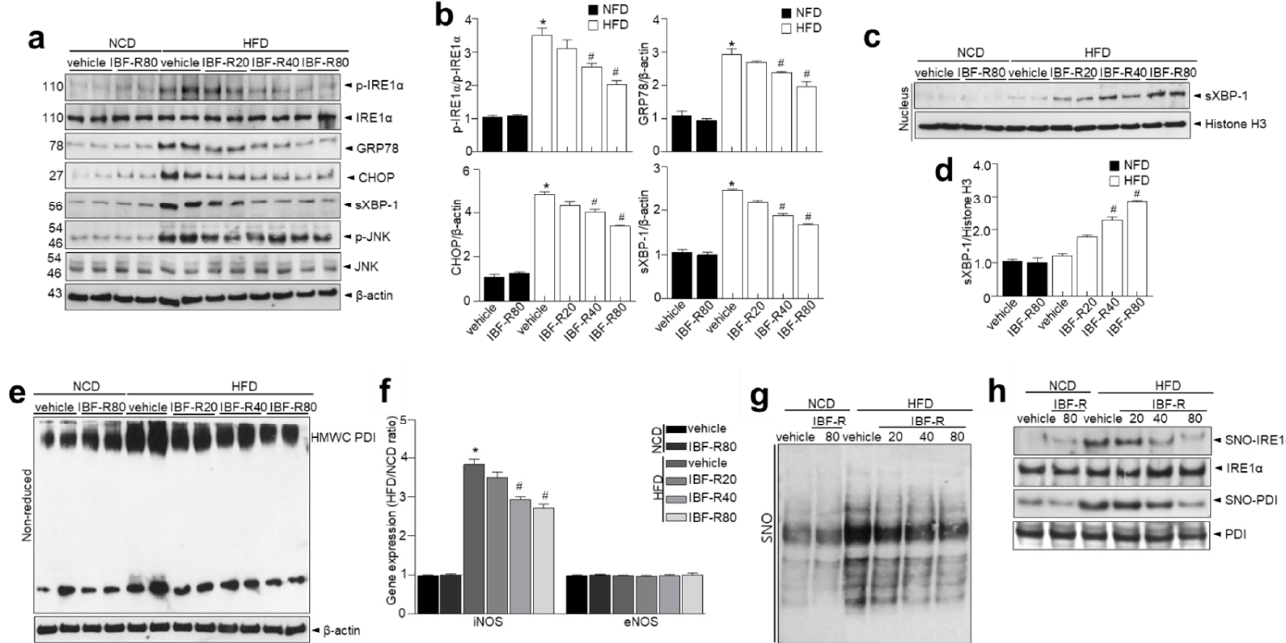
Figure 3. IBF-R diminish ER stress and IRE1 α S-nitrosylation of axis in HFD model. ( a ) Immunoblotting of p-IRE1 α , IRE1 α , GRP78, CHOP, sXBP-1, and β -actin expressions in eWAT. ( b ) Quantitative analysis of proteins. ( c , d ) sXBP1 expressions at the nuclear level from each group and quantitative analysis. ( e ) eWAT lysate was examined for PDI in HMWCs on non-reducing gels. ( f ) iNOS and eNOS mRNAs were measured in eWAT by qRT-PCR. ( g ) General S-nitrosylation (SNO) profile in eWAT of HFD mice and NCD controls. ( h ) Specific SNO proteins in the eWAT of HFD mice and NCD controls. S-nitrosylated proteins were purified with biotin-switch assay and detected by immunoblotting. Data are shown as mean ± SEM ( n = 10, * p < 0.05 vs. NCD + vehicle, # p < 0.05 vs. HFD + vehicle). eWAT; epididymal white adipose tissue.